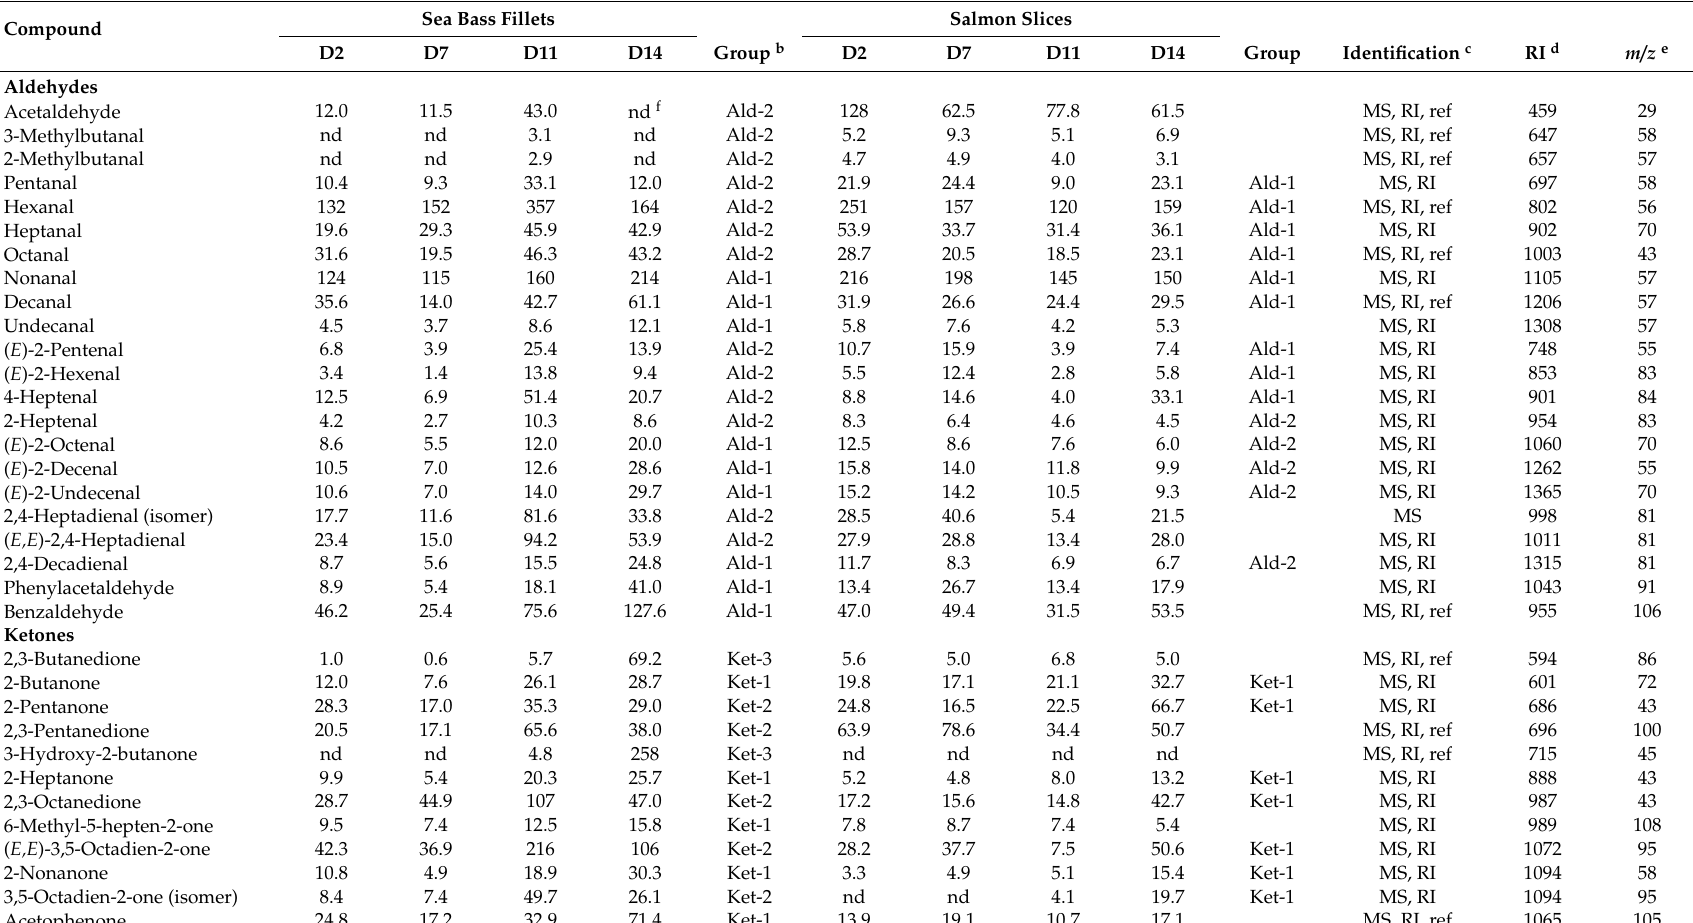
Table 1. Relative concentrations a of volatile compounds in sea bass fillets and salmon slices during storage under MAP at 2 ◦